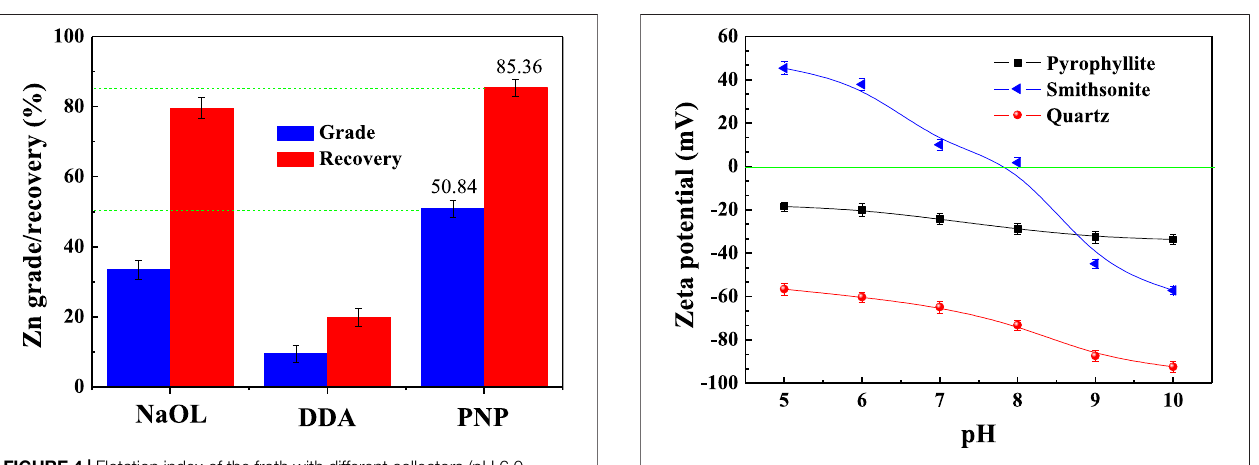
and quartz particles.